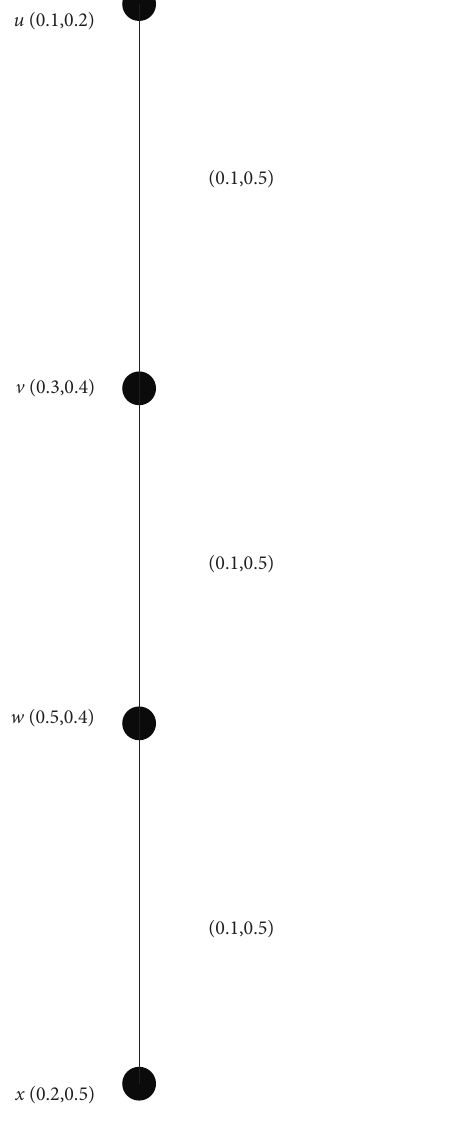
Figure 4: Vague graph G . Table 2: Name of employees in a hospital and their services. Name